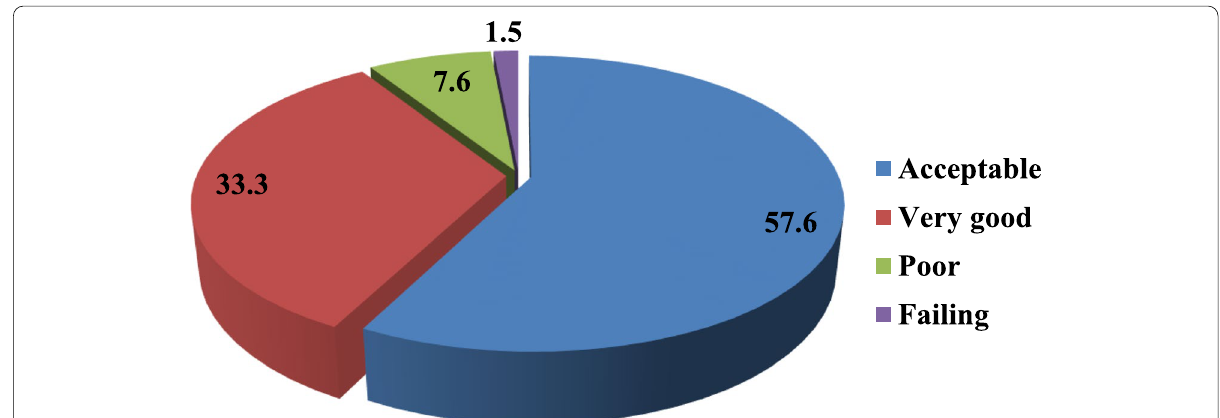
Fig. 2 Participants’ grading of patient safety within the working unit, University Hospital for Gynecology and Obstetrics, Alexandria, Egypt, November 2020 to January